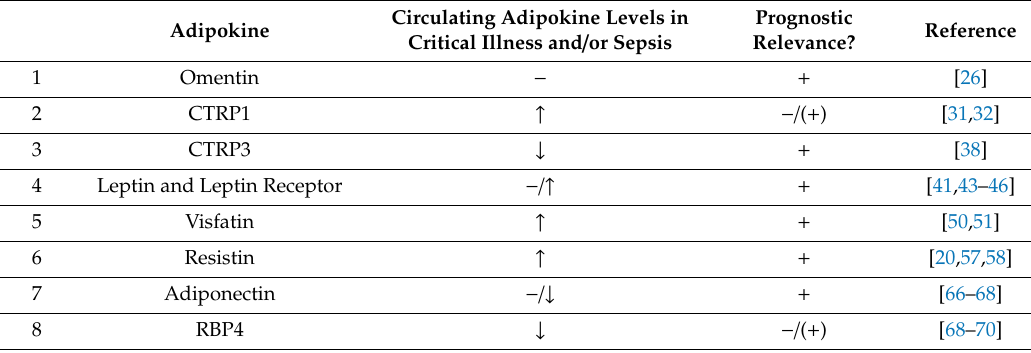
Table 1. Overview of regulated adipokines in critically illness and sepsis. Circulating Adipokine Levels in Adipokine Critical Illness and / or Sepsis